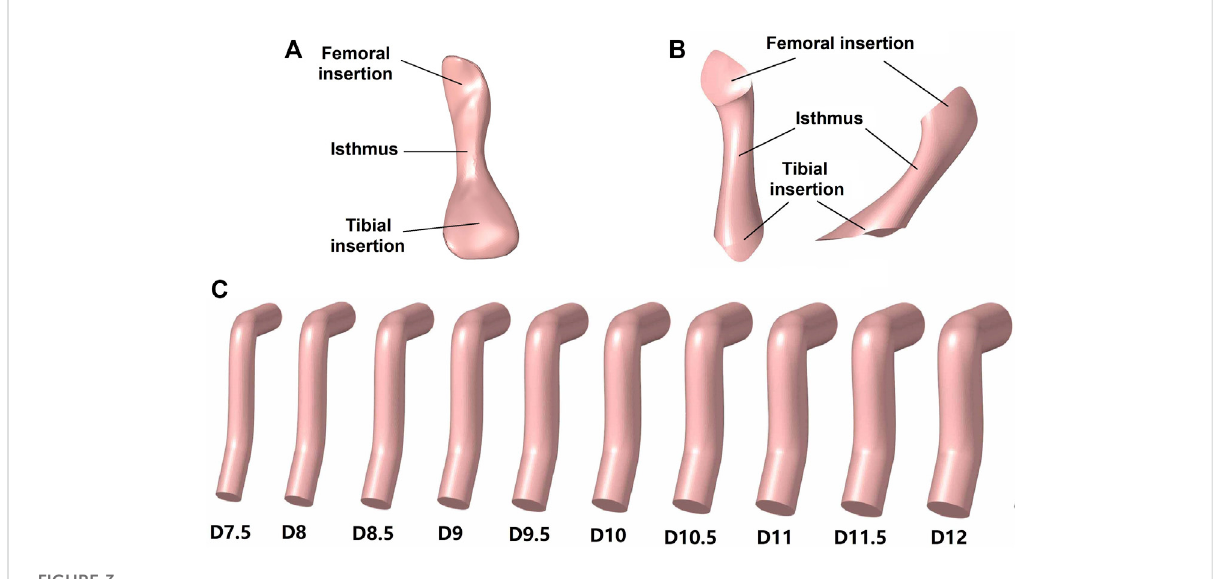
FIGURE 3 Models of the ACL and grafts. (A) Native ACL; (B) Hourglass-shaped ACL; (C) Columnar grafts with different diameters